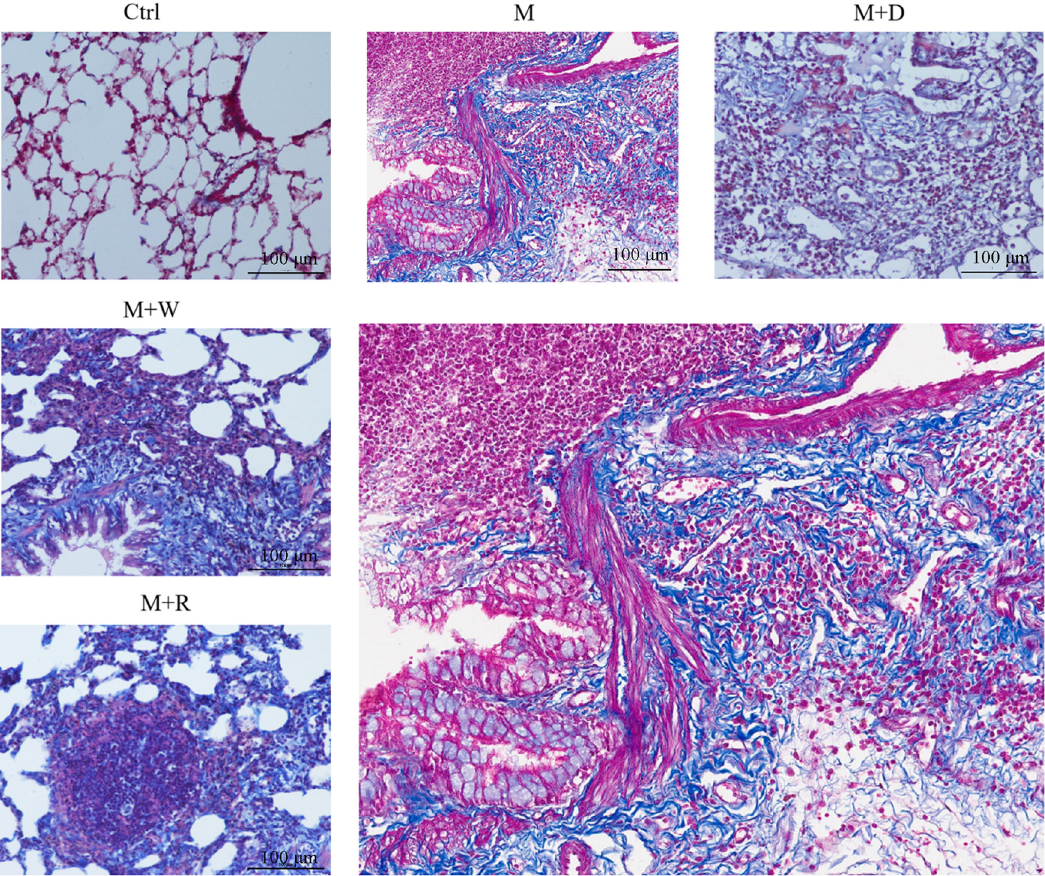
Figure 1: Masson staining pathological images of rat lung tissues in each group ( Masson staining, 200 × . The large image is the enlarged version of the group M image )